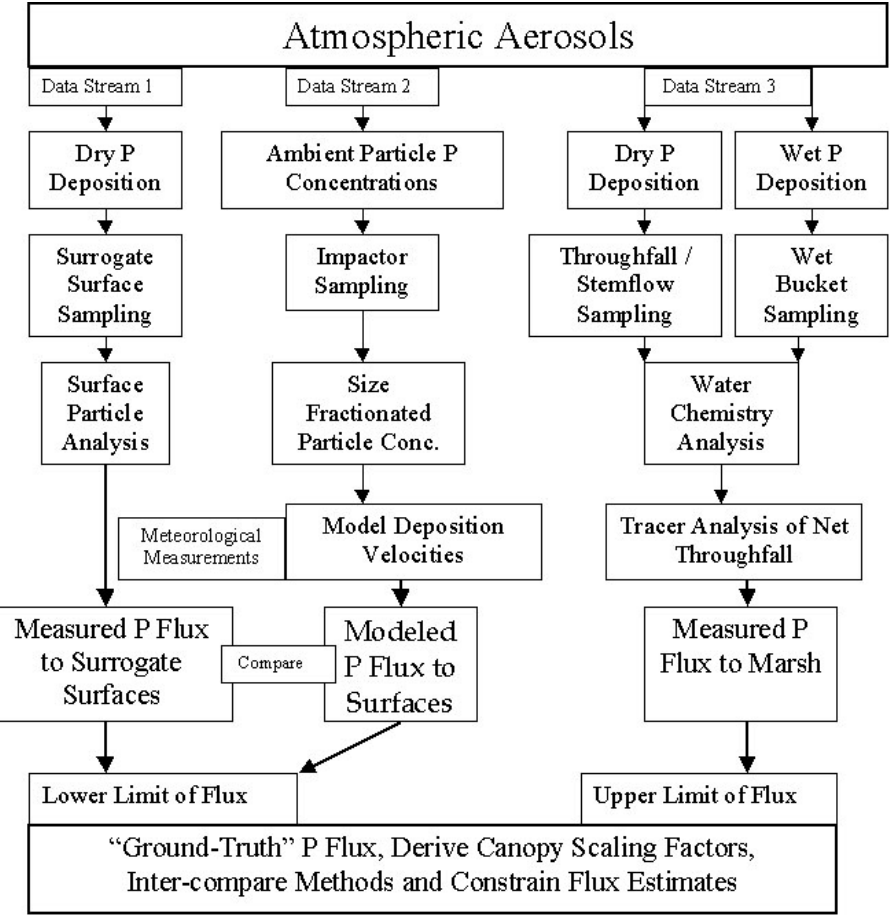
FIGURE 3. A diagrammatic representation of the experimental plan proposed by Pollman et al.[45] to improve estimates of P deposition. The plan features three data streams leading to three comparable sets of flux estimates. This figure is a major revision of Fig. 3 from Pollman et al.[45], and the author is solely responsible for its